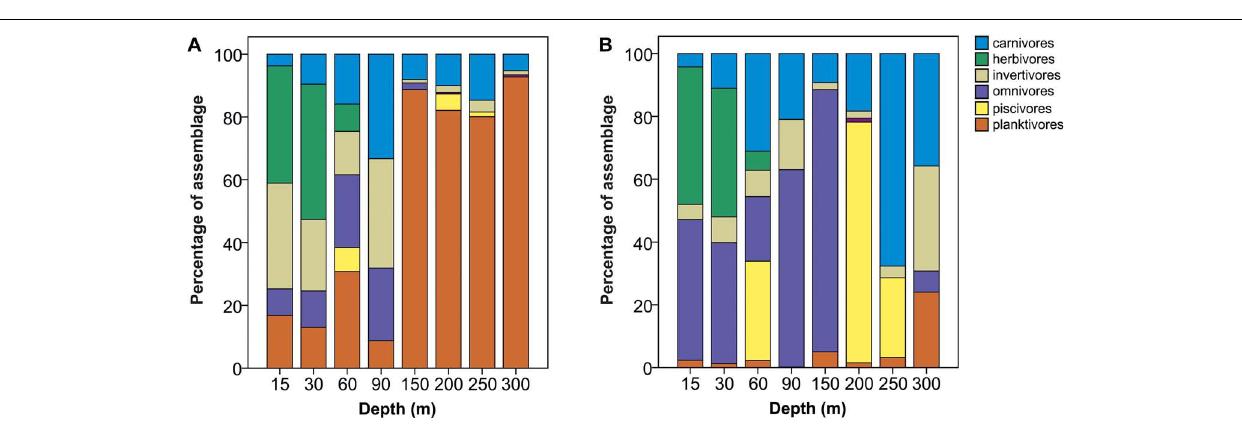
FIGURE 5 | Comparison of changes in relative contribution (percentage of total fish assemblage) of trophic groups with depth using (A) abundance and (B) biomass data, respectively. Percentage abundance and biomass for each trophic group was calculated by summing all fish on all transects at all sites in a depth